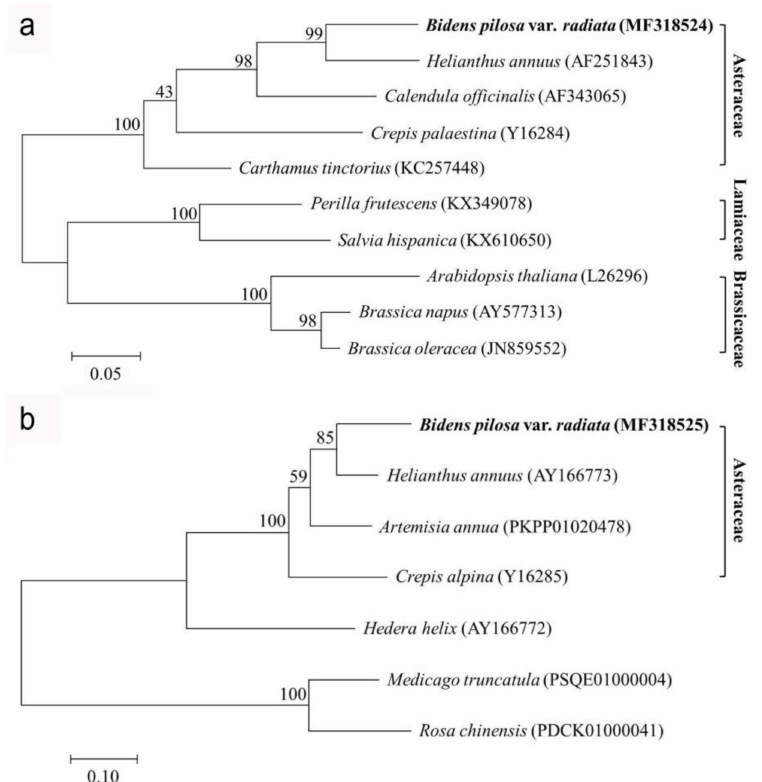
Figure 3. Phylogenetic relationships of ( a ) oleate desaturase (OD) and ( b ) fatty acid acetylenase (FAA) genes based on their complete coding DNA sequences (CDSs). The numbers in brackets are the accession numbers of the OD and FAA sequences. Molecular phylogenetic analyses were conducted using the Maximum Likelihood method based on the Tamura–Nei model [29]. Bootstrap values at the nodes are the percentages of 1000